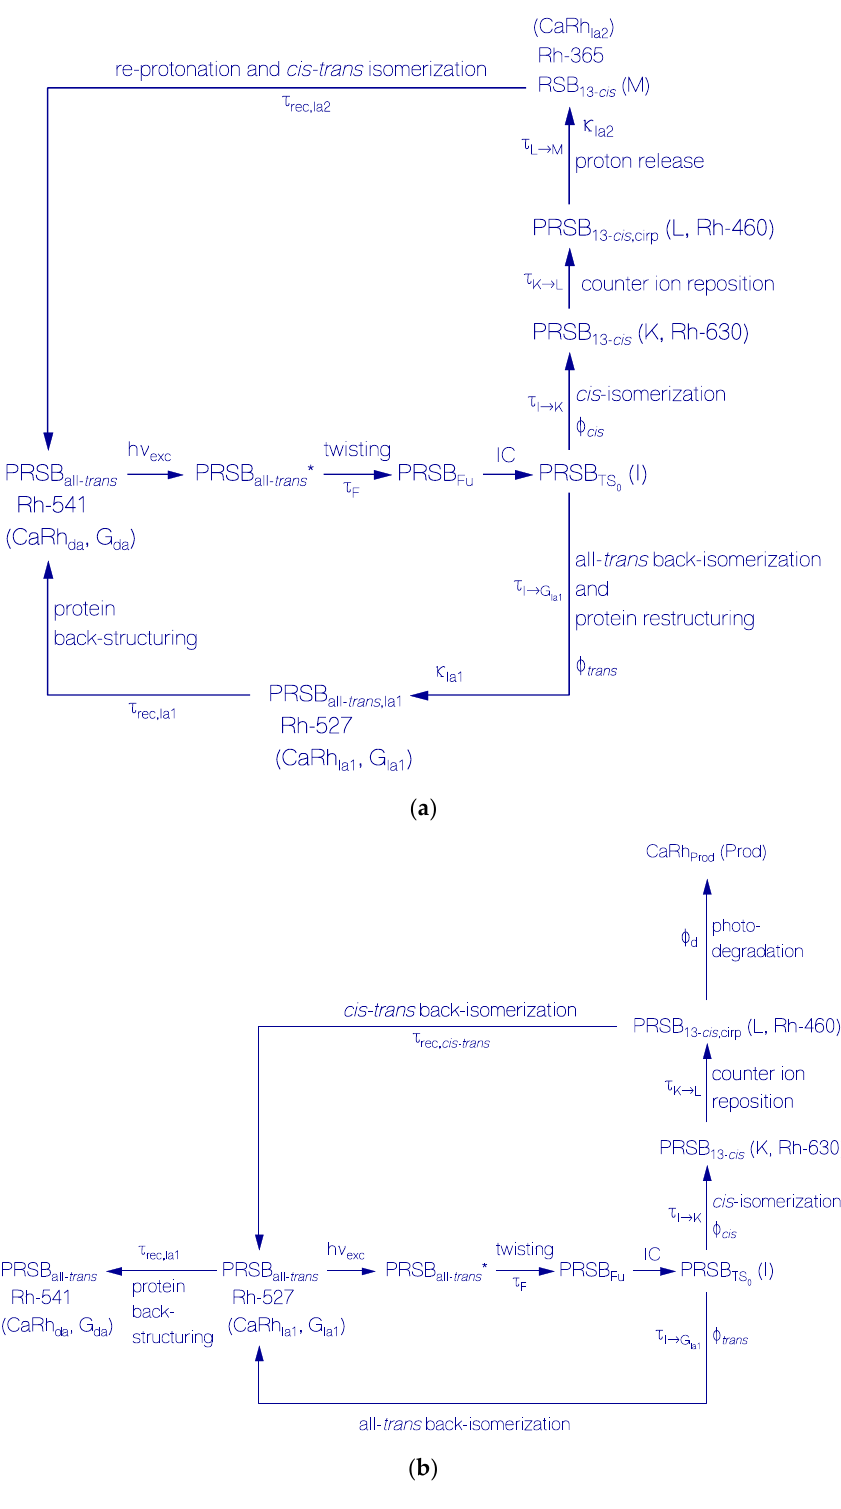
Figure 13. ( a ) Scheme of primary photocycle dynamics (upper part) and all- trans back-isomerization with opsin restructuring cycle (lower part) of CaRh in pH 7.3 HEPES/MOPS buffer; ( b ) Scheme of secondary photocycle dynamics including photo-degradation, all- trans back-isomerization and light-adapted (la1) to dark-adapted (da) ground-state relaxation of CaRh in pH 7.3 HEPES/MOPS buffer.